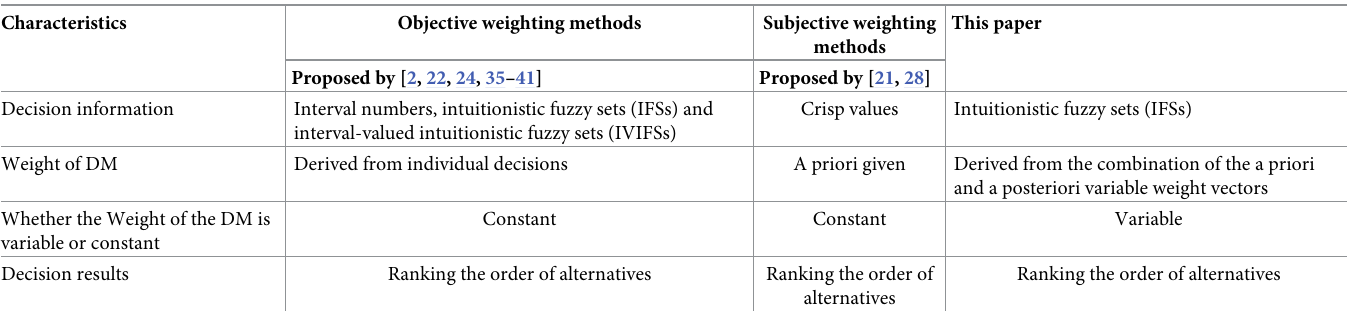
Table 1. Comparisons between our approach and the two related approaches.